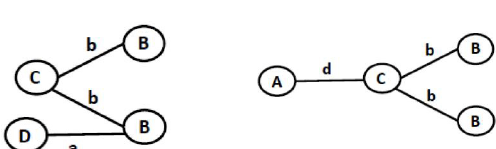
Fig. 25 Structures retained ( G 1 ; G 2 ).